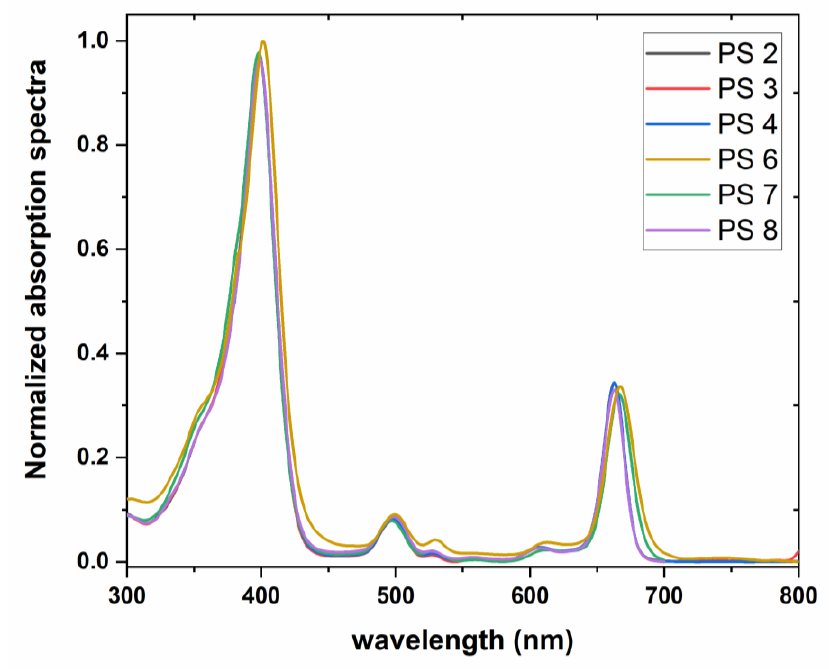
Figure 2. UV-vis absorption spectra of chlorophyll a derivatives 2 – 4 and 6 – 8 in ethyl acetate.